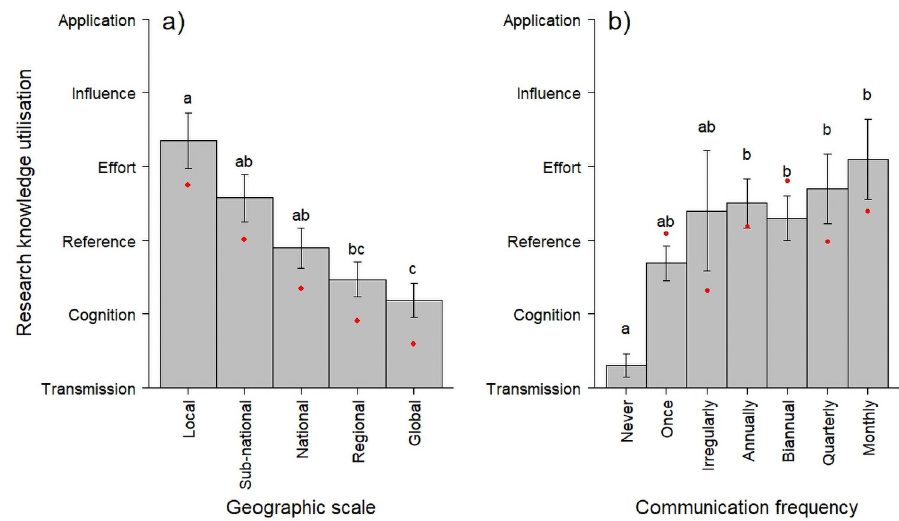
Fig 1. a) The relationship between geographic scale and the extent of achieved RKU and b) the extent of achieved RKU as a function of the frequency of communication of research findings to stakeholders. The level of utilisation is plotted on the scale defined in [20]. Bars indicate the means of the responses and error bars indicate one standard error measure of the mean. The dots indicate the predicted means. The first dot in Fig 1b would be located below the